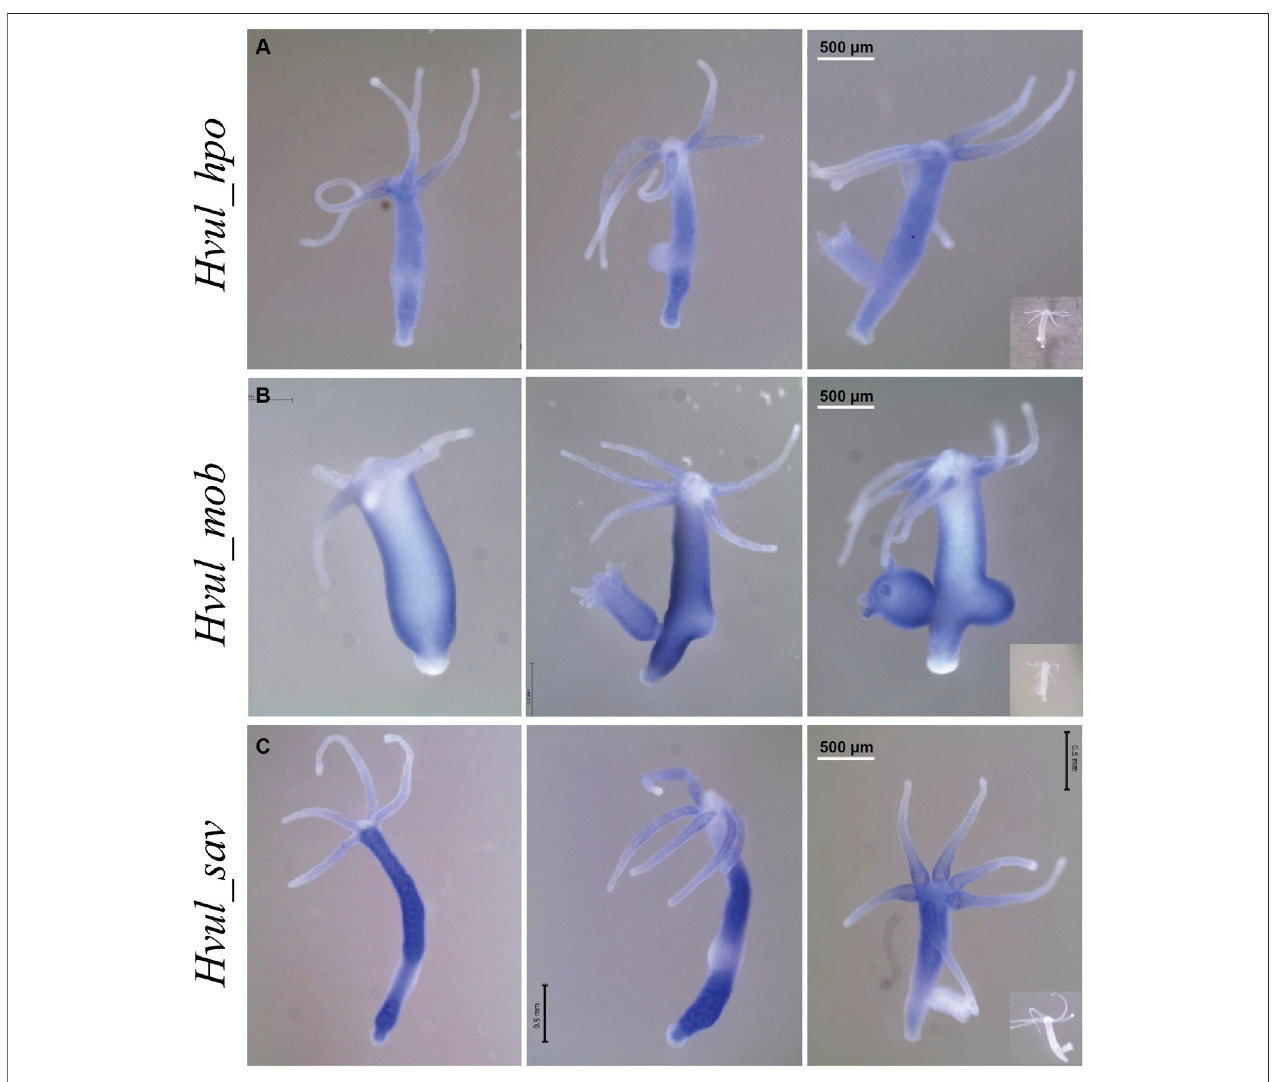
FIGURE 4 | Hvul_hpo , Hvul_mob and Hvul_sav expression analysis in Hydra . Whole mount in situ hybridization of (A) Hvul_hpo , (B) Hvul_mob and (C) Hvul_sav expression for the whole polyp. The insets on the right indicate negative controls probed with sense RNA probe. (The scale bar is 500 µm long, N (cid:2) 3).